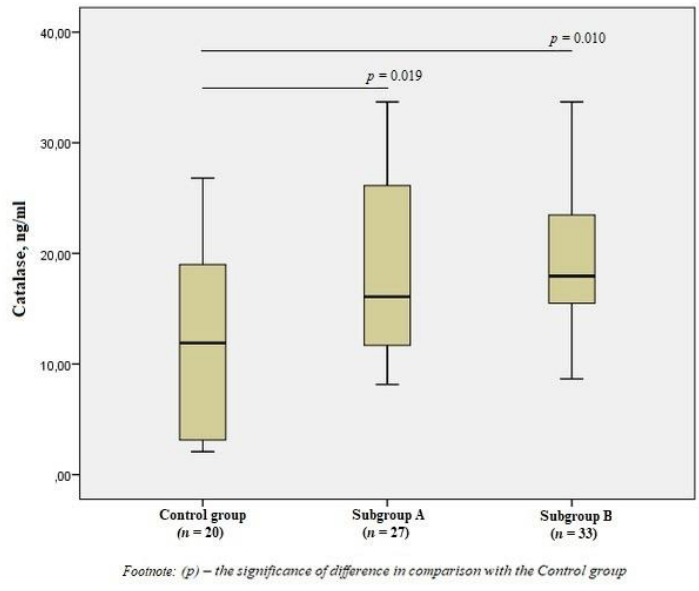
Figure 3. The blood catalase levels in the group of men without ischemic artery disease (Control group), in the subgroup of men with ischemic artery disease and the presence of vulnerable atherosclerotic plaques in the coronary arteries (Subgroup A) and the subgroup of men with ischemic artery disease and the absence of vulnerable atherosclerotic plaques (Subgroup B), Me (25%; 75%). p — the significance of difference in comparison with the Control group.